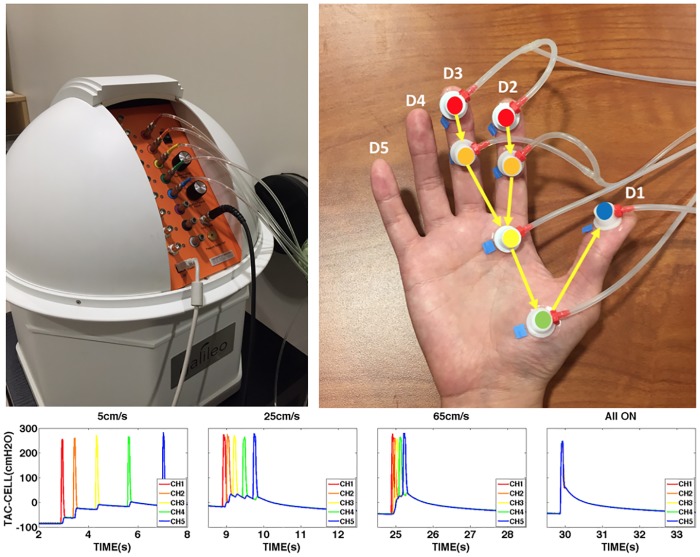
Galileo somatosensory™ tactile stimulation.Top Left: Galileo somatosensory™ tactile stimulator. Top Right: Stimulated areas and TAC-Cells location. p1 in D2 and D3 = red, p2 in D2 and D3 = orange, p4 in D2 and D3 = yellow, p4 in D1 = green, p1 in D1 = blue. The TAC-Cell is essentially a small capsule (OD = 15 mm, ID = 6 mm), and machined from acetal thermoplastic. Bottom: Stimulus velocity pressure waveforms for each condition.